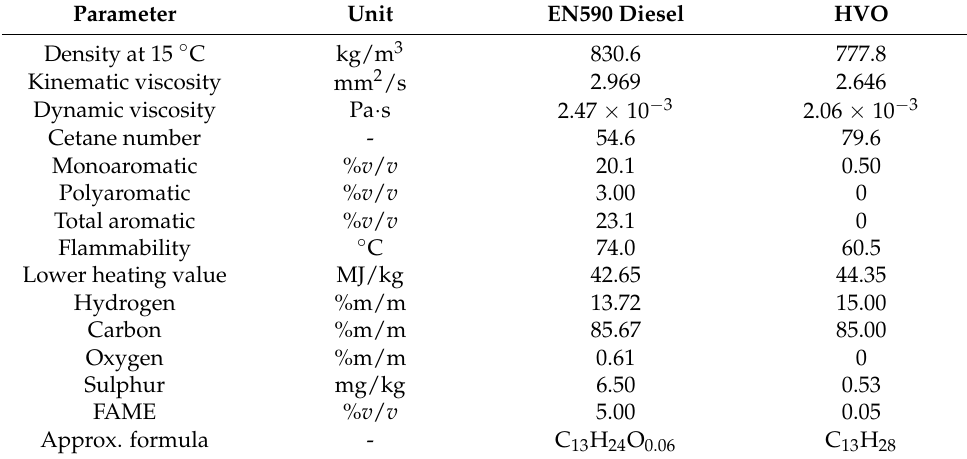
Table 4. Diesel vs. HVO main